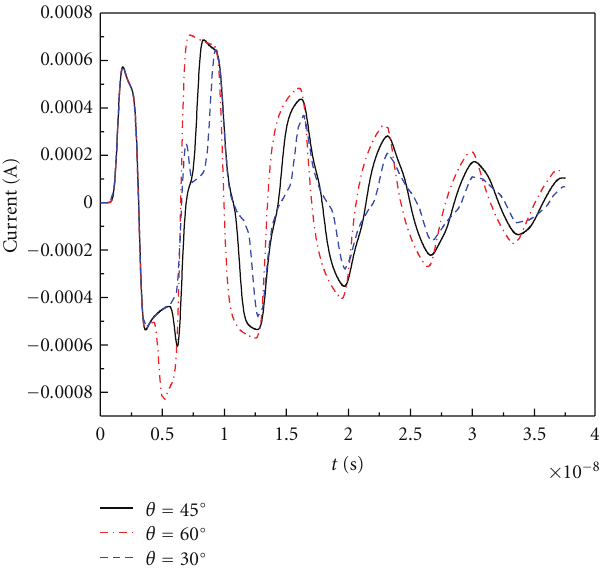
Figure 7: The transient current induced at midpoint of thin wire above half-space with di ff erent incident angles.